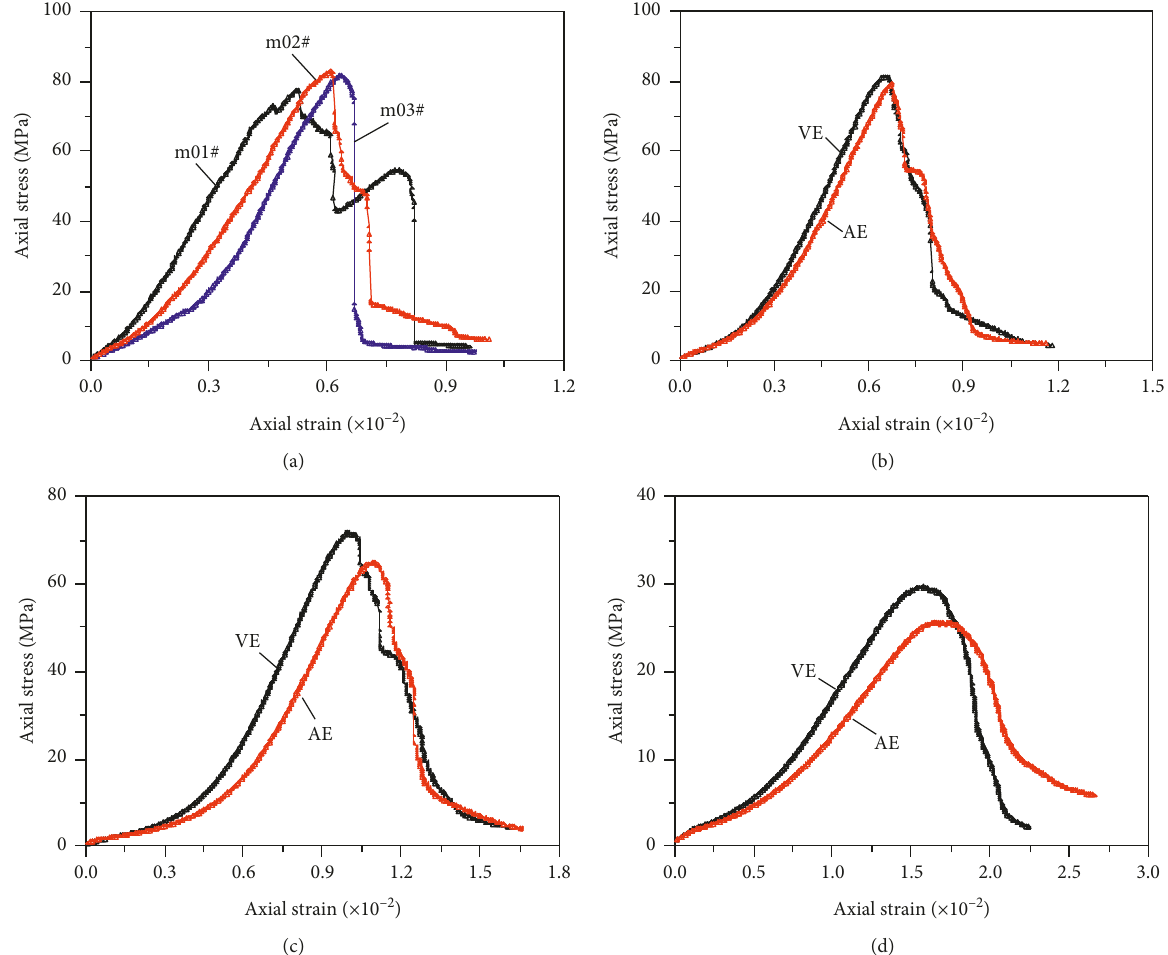
Figure 2: Axial stress-strain curves of marble specimens under uniaxial compression: (a) 25, (b) 300, (c) 600, and (d) 900 ° C.